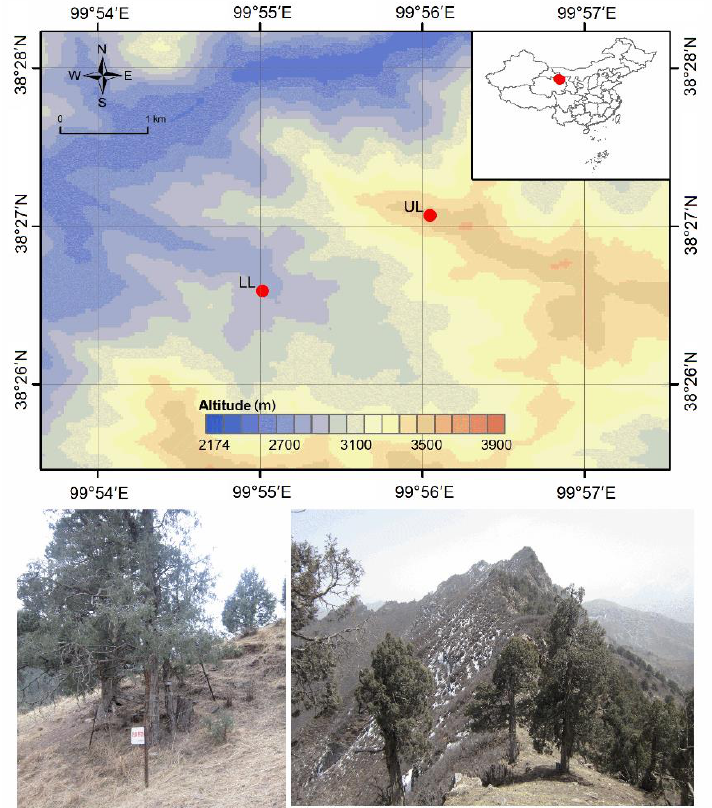
Figure 1. Locations and images of the study sites at Sidalong Forestry Station, a semi-arid area of northwestern China.